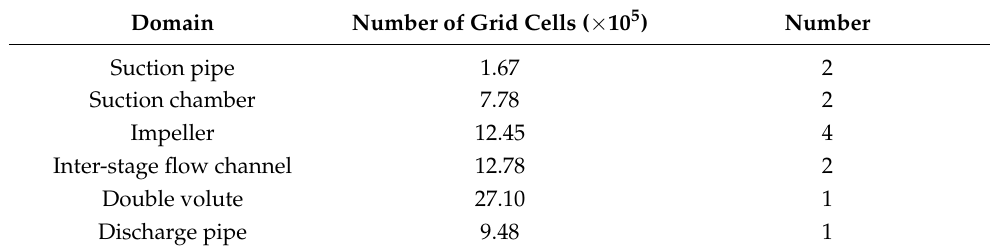
Table 3. The number of grid cells for each computational domain.